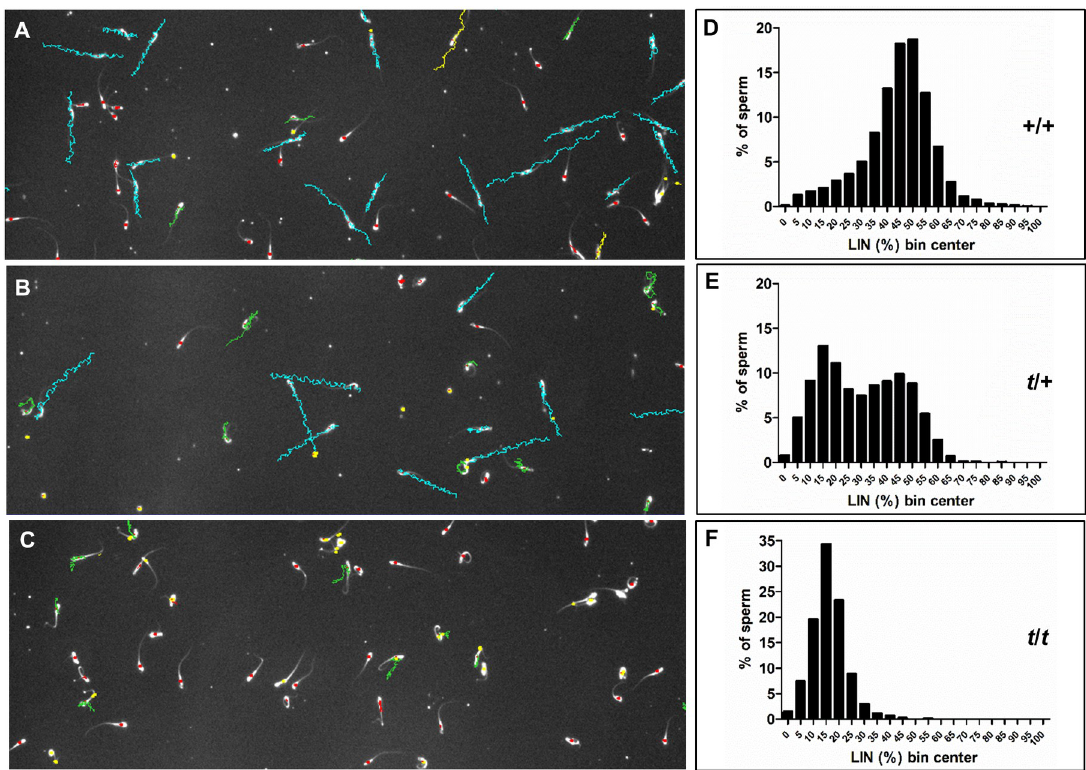
Fig 4. Motility tracks and linearity profiles of sperm from different genotypes. (A, B, C) Representative sperm tracks of +/+ (A), t /+ (B) and t / t (C) samples generated by CASA (computer assisted sperm motility analysis). Tracks color code: blue–progressive; green–less progressive; red–immotile (excluded from analysis); yellow–late tracks (recording started after the first 10 frames; excluded from analysis). (D, E, F). Histograms showing the frequency distribution of sperm over linearity (LIN; %) bins in +/+ (D; n = 7151 sperm), t /+ (E; n = 8335 sperm) and t / t (F; n = 813 sperm) samples (n = 15 samples each).